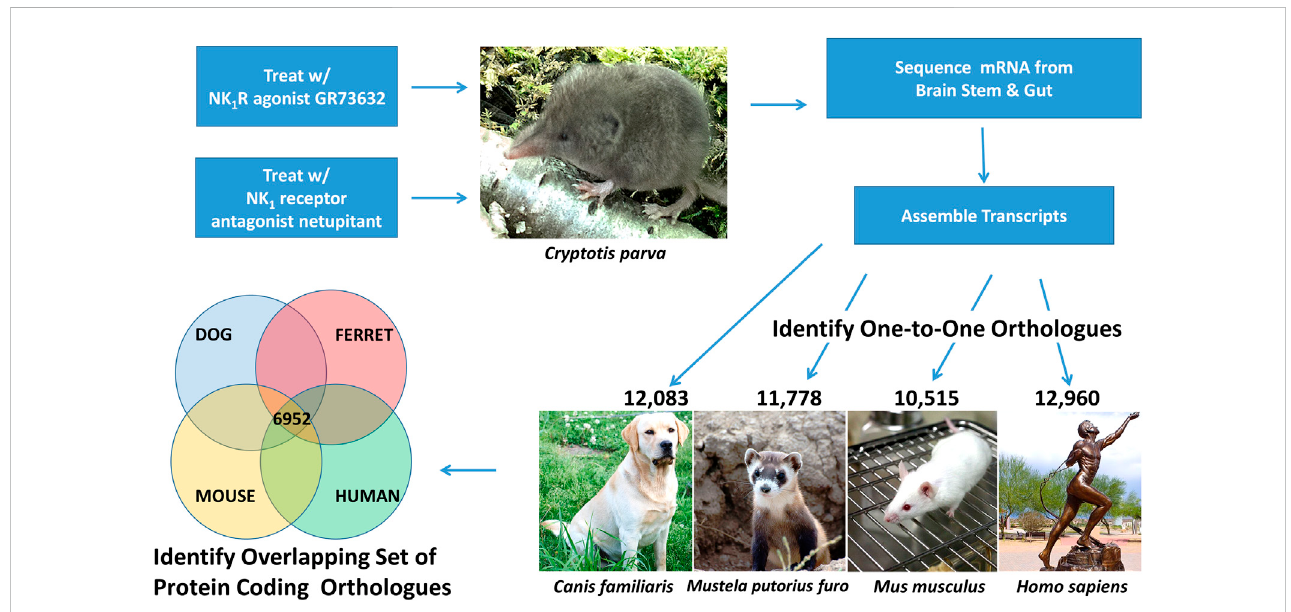
FIGURE 1 Overview of RNA Sequencing Study Design. This genomics study investigated the transcripts induced in the brain stem and gut following least shrew ( Cryptotis parva ) treatment with an NK 1 R agonist (GR73632) and an NK 1 R antagonist (netupitant). Brain stem and gut transcripts were assembled from overlapping RNA sequencing reads and one-to-one orthologs between shrew and dog ( Canis familiaris ), ferret ( Mustela putorius furo ), mouse ( Mus musculus ), and human ( Homo sapiens ). The resulting ortholgous sequences were used to identify a set of 6,952 shared orthologs across all fi ve species (shrew, dog, ferret, mouse, human). Images of each species were acquired from the open source image repository wikimedia.org (https://commons. wikimedia.org): dog (Afra_008.jpg), ferret (Iltisfrettchen.jpg), mouse (Lab_mouse_mg_3158.jpg), human (Bronze_anatomical_ fi gure,_Europe_Wellcome_ L0058953.jpg), shrew